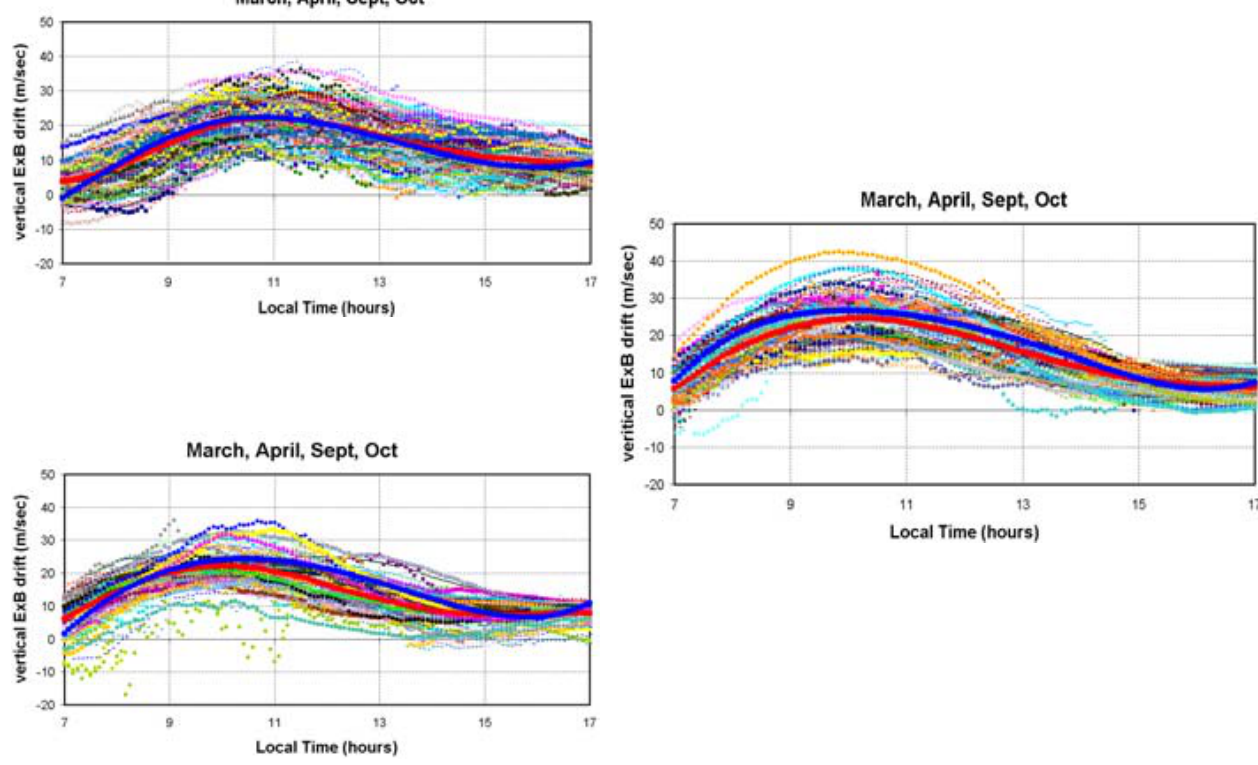
Figure 1. Average ∆ H-inferred ExB drifts (red curve) compared with the Scherliess-Fejer climatological model (blue curve) in the Peruvian (top), Philippine (right figure) and Indian (bottom) longitude sectors. The thin line colored curves in each figure represent individual, quiet day curves for each sector – Peruvian (165 days), Philippine (129 days) and Indian (92 days) (see text for details).